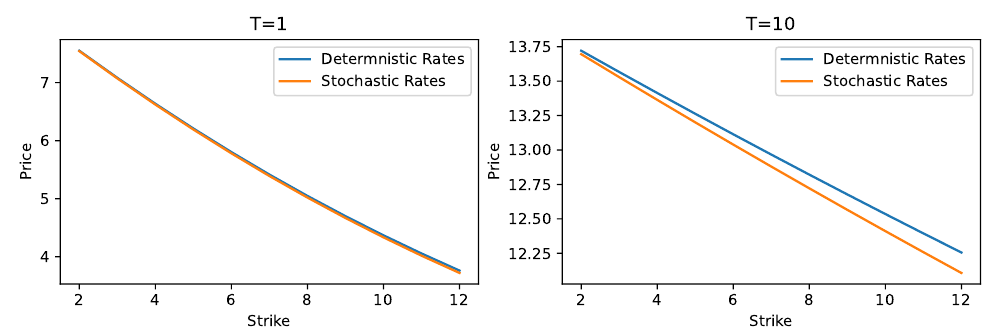
= − 0.75, and ρ x = − 2 , r 1 , r